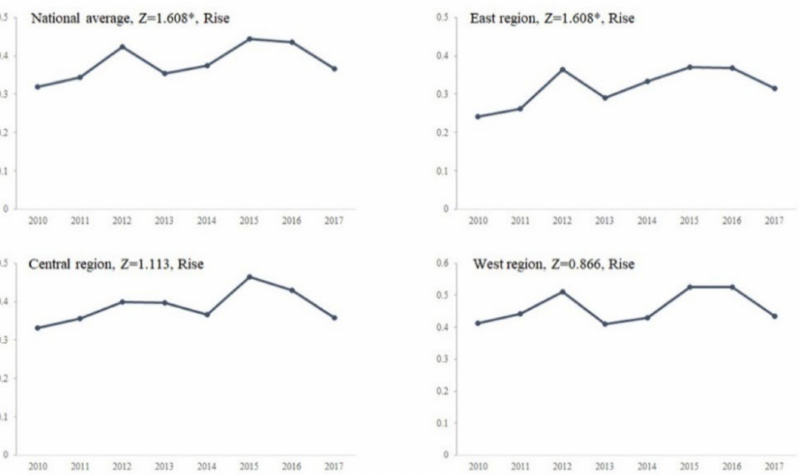
Figure 5. Change trend and test of coupling coordination degree from 2010 to 2017. (Notes: “*” indicates that it has passed the 90% confidence